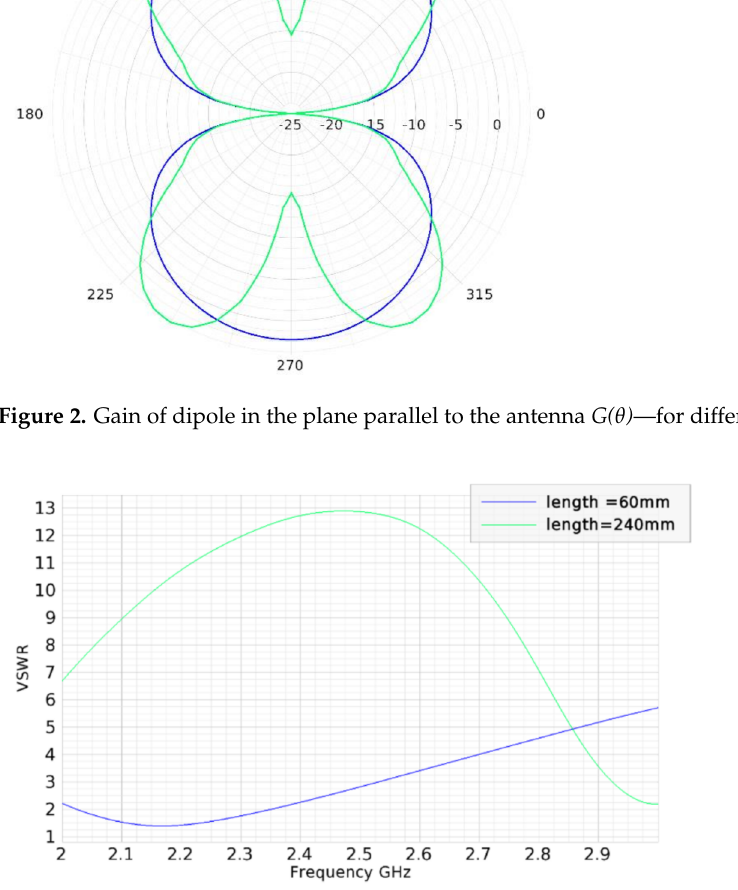
Figure 3. Impedance matching of dipole antenna for different antenna